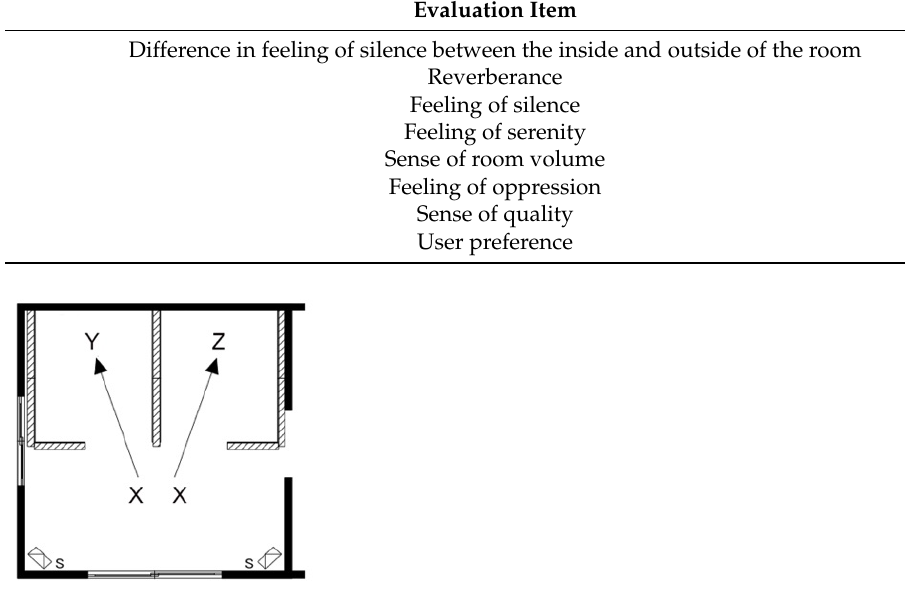
Figure 4. Two evaluation spaces used for the Nakaya’s modified method of Scheffé’s paired comparisons. The participants experience the two evaluation spaces successively and state the differences between these two spaces for eight subjective items.